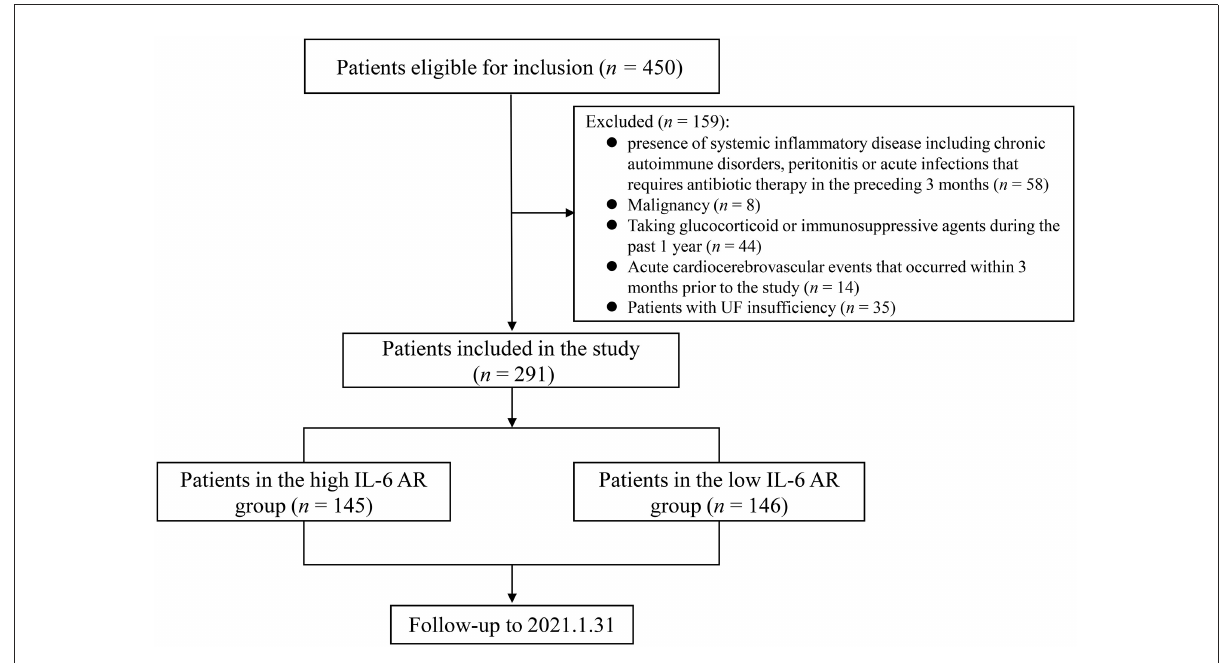
FIGURE1 Flowchart of patient inclusion in analysis. AR, appearance rate.